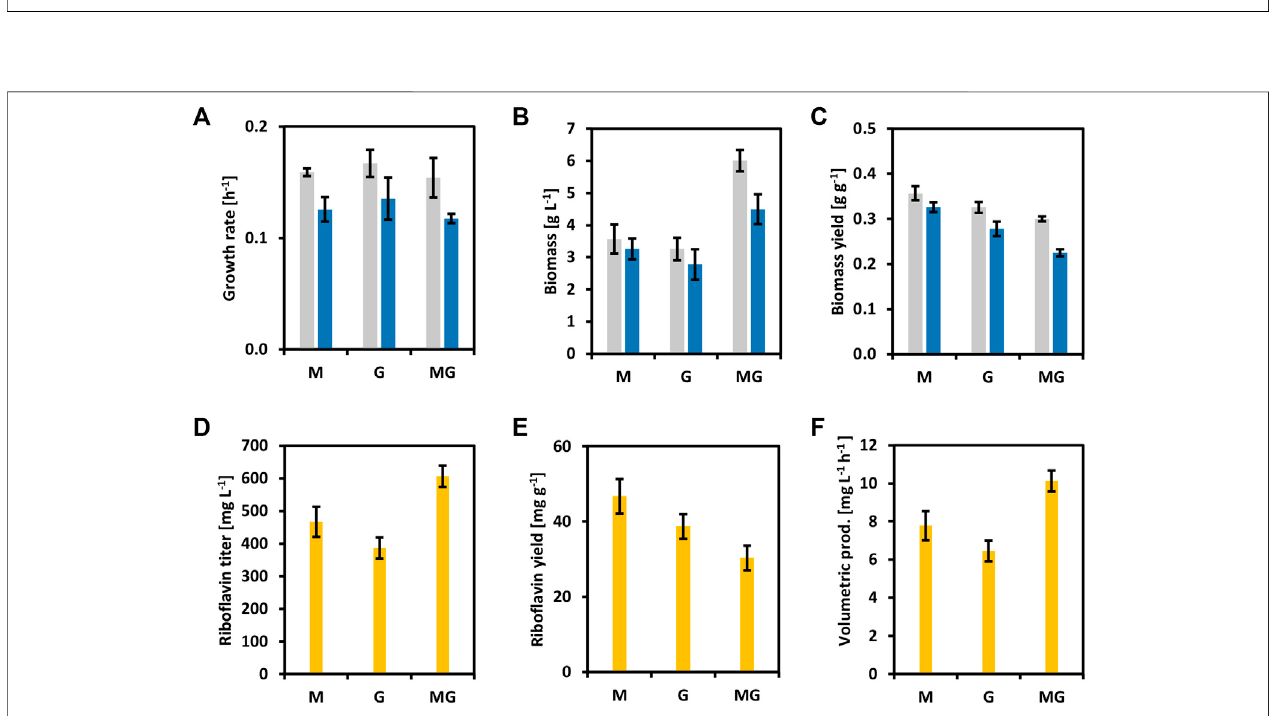
FIGURE6| Growthandribo fl avinproductionfrombrownseaweedsugarsofthestrainsCgRibo3andCgRibo4.1%ofglucose,1%ofmannitol,and1%ofglucose and 1% of mannitol were assayed. (A) Growth rates (h − 1 ) of CgRibo3 and CgRibo4. (B) Final biomasses of formed (g L − 1 ) CgRibo3 and CgRibo4. (C) Biomass yields (g g − 1 )ofCgRibo3andCgRibo4. (D) Finalribo fl avintiters(mgL − 1 )ofCgRibo4. (E) Ribo fl avinyields(mgg − 1 )ofCgRibo4. (F) Ribo fl avinvolumetricproductivities(mgL − 1 h − 1 ) ofCgRibo4.Growth valuesofCgRibo3are depicted withgrey columns. Growth values ofCgRibo4 are depicted with blue columns. Productionvalues ofCgRibo4 are depicted with yellow columns. Means and standard deviations of triplicates are shown.